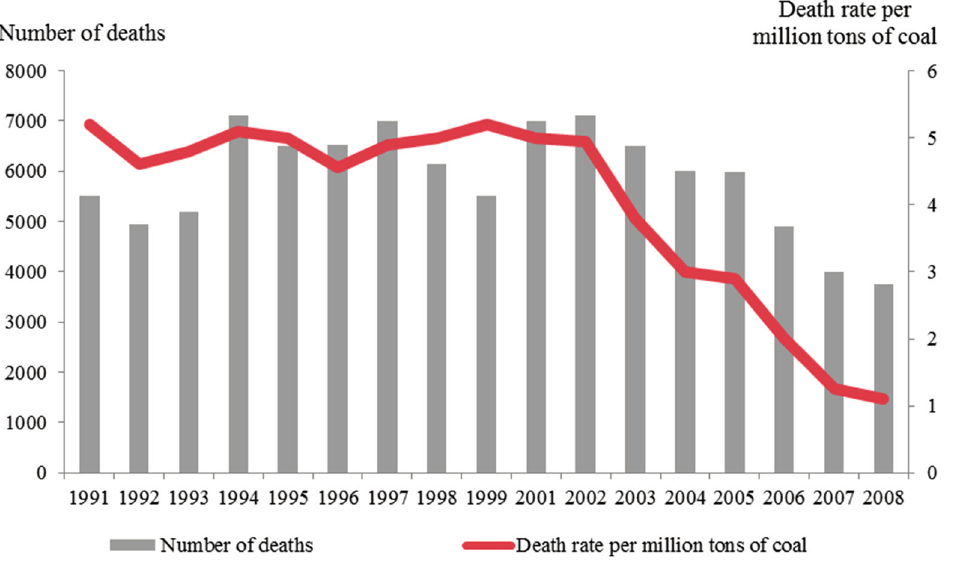
Figure 2. Number of people killed in coal mine accidents and death rate per million tons of coal.